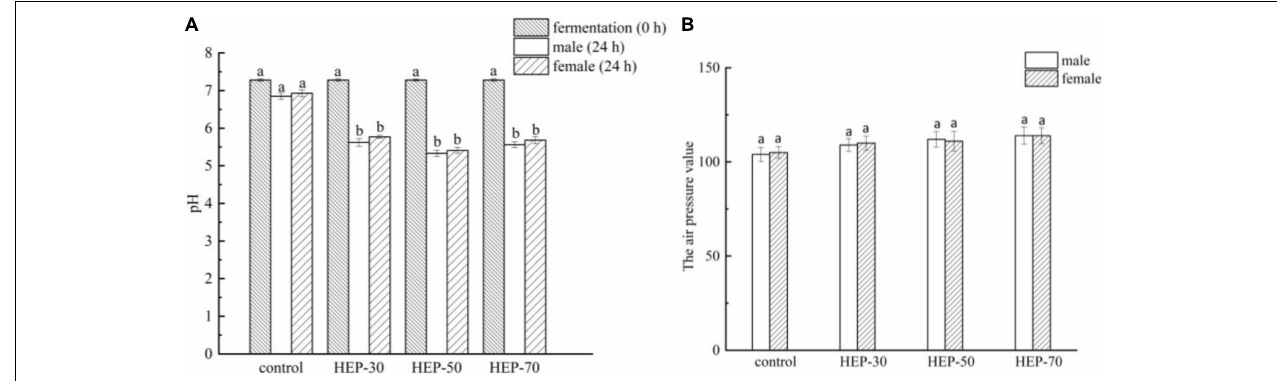
FIGURE 5 | The pH value (A) and air pressure (B) changed in different groups during in vitro fermentation of human feces. Different letters indicated a significant difference between the two groups ( p < 0.05). Data are means ± SD (3 independent experiments × 3 replication). a , b Different lowercase letters indicate significant differences ( p < 0.05) between fermentation 0 and 24 h.